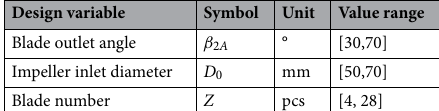
Table 7. Design variables and their value